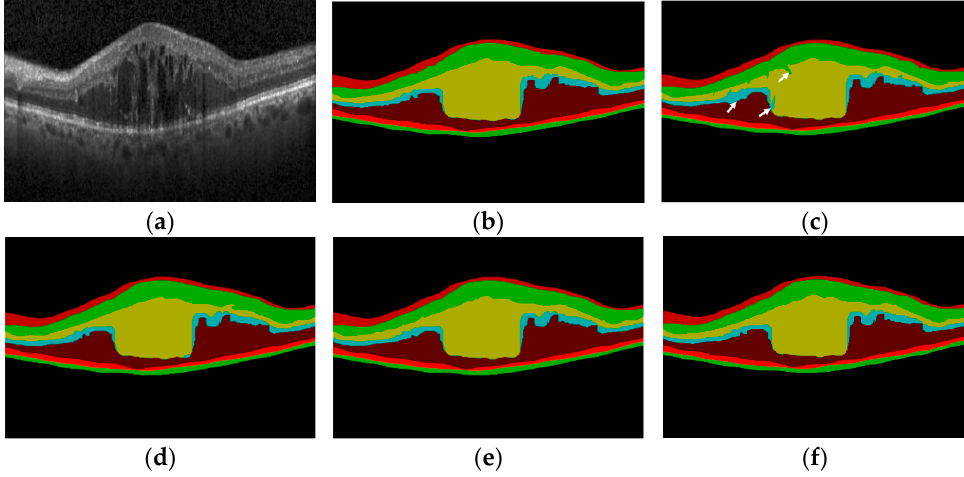
Figure 9. Comparison of ablation experiments: ( a ) The original image; ( b ) Expert 1 annotation; ( c ) Baseline 1; ( d ) Baseline 2; ( e ) Baseline 3; ( f ) the proposed method.